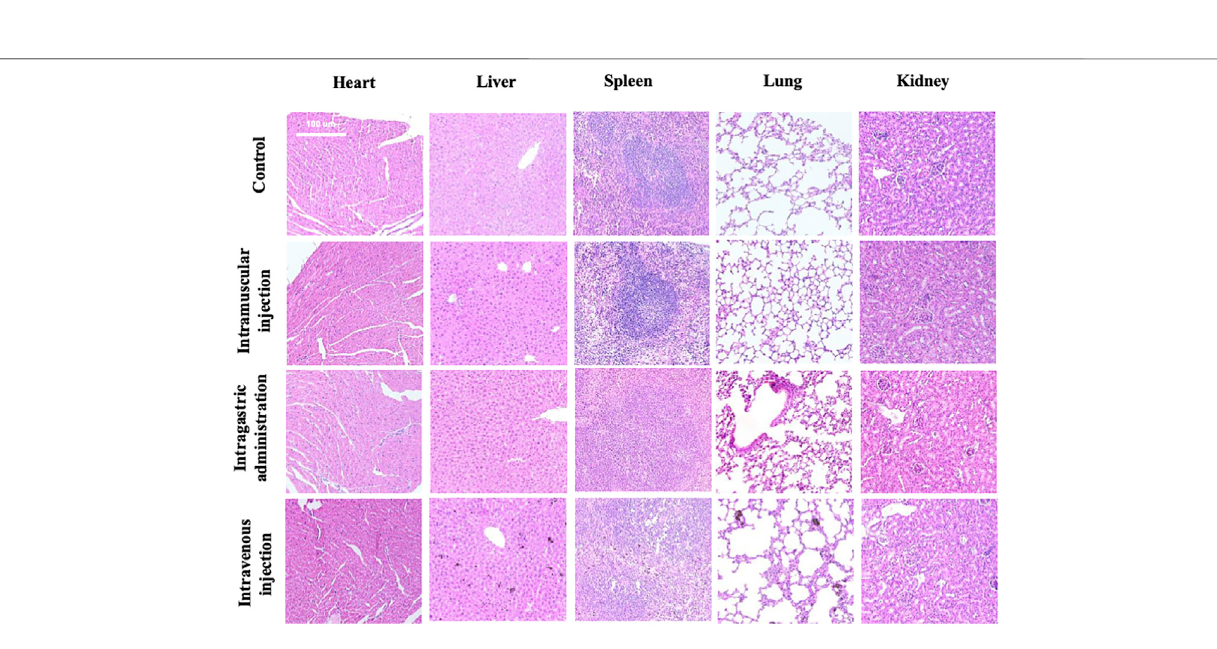
Frontiers in Bioengineering and Biotechnology |